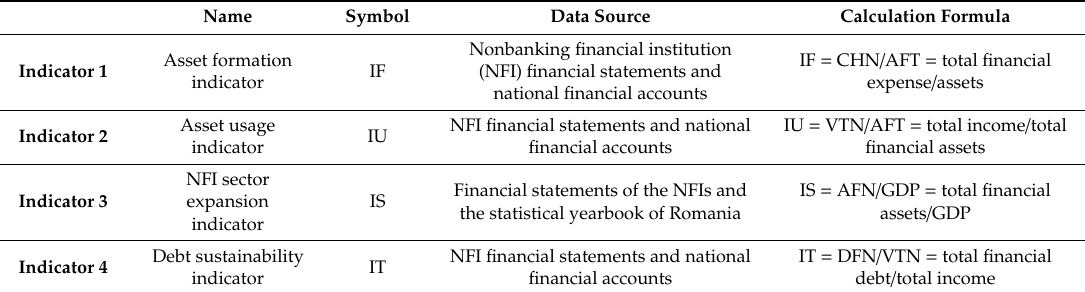
Table 1. Parameters of the four indicators used in the